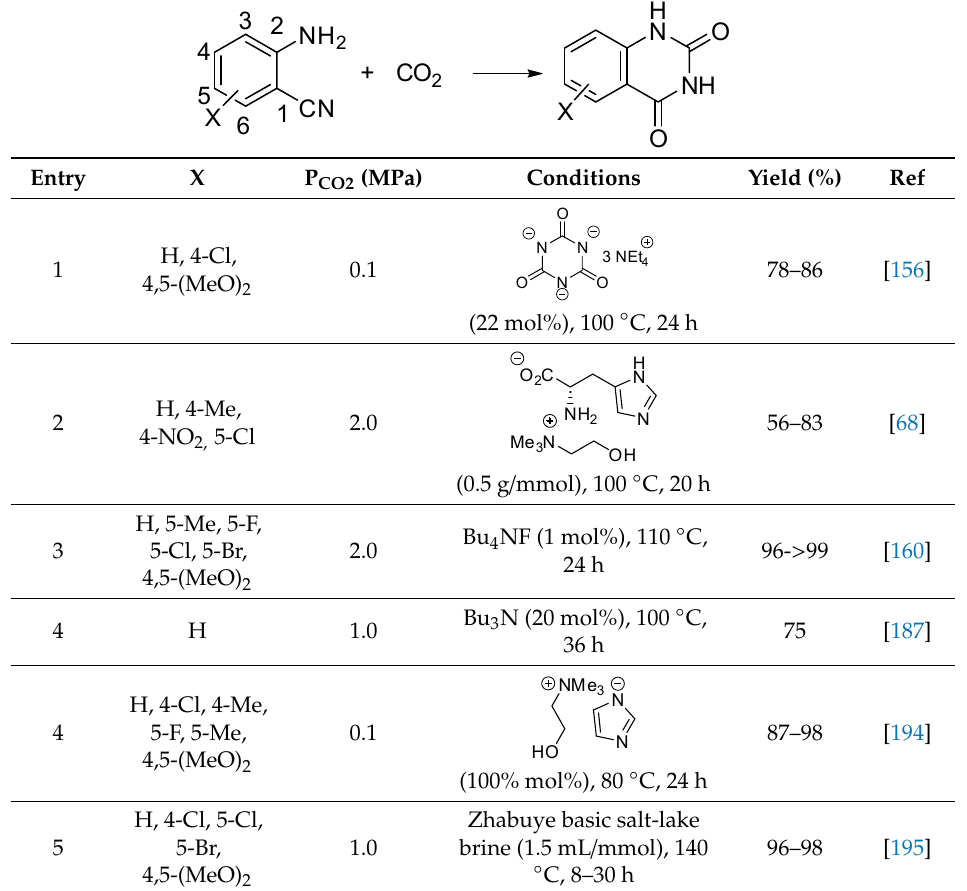
Table 5. Catalysts for the reaction of 2-aminobenzonitriles and CO 2.